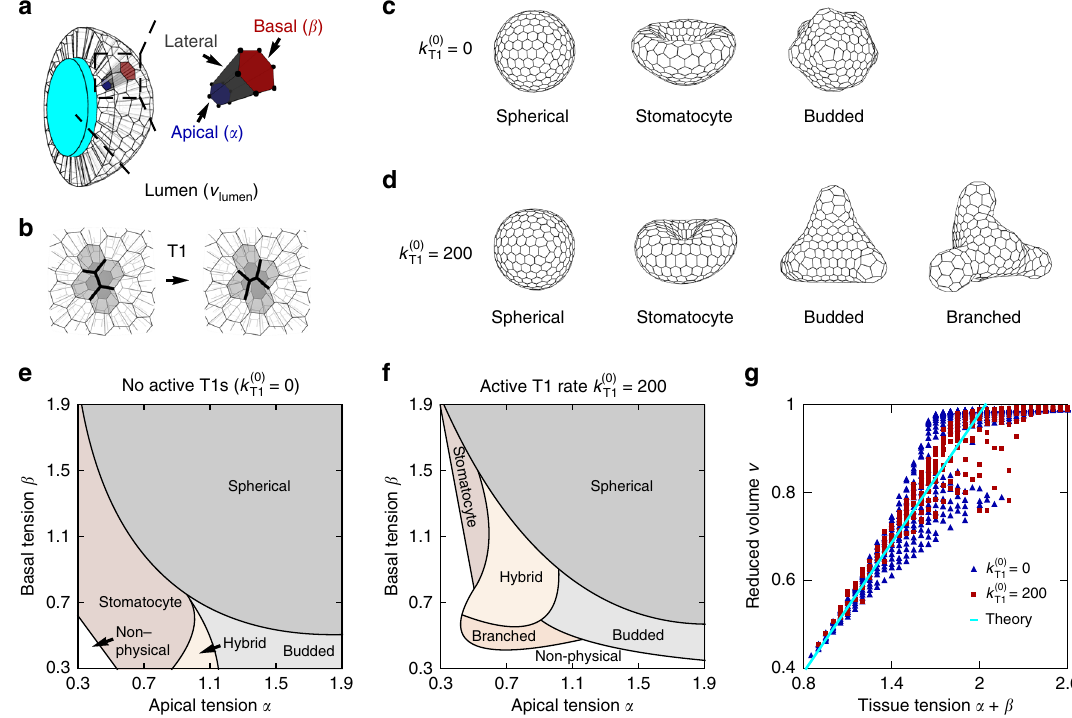
Fig. 1 Mechanical model predicts several characteristic morphologies. a Schematics of the model epithelial shell with a lumen of volume v lumen (expressed in units of cell volume V cell ) indicated in cyan, and a cell with apical, lateral, and basal sides; also indicated are the dimensionless apical and basal tensions α and β , respectively. b T1 transition. c Representative shapes with N c = 300 cells, v lumen = 100, and k ð 0 Þ stomatocyte ( α = 0.7, β = 0.5), and budded ( α = 1.5, β = 0.3) morphologies. Panel d shows model epithelial shells at the same N c and v lumen but with k ð 0 Þ ¼ 200: spherical ( α = 1.2, β = 1.2), stomatocyte ( α = 0.5, β = 1.1), budded ( α = 1.1, β = 0.5), and branched ( α = 0.7, β = 0.5) morphologies. e Phase T 1 ¼ 0 shapes in the ( α , β ) plane. f Phase diagram at the same N diagram of the N c = 300, v lumen = 100, and k ð 0 Þ T 1 g Reduced volume v vs. tissue tension α + β . The solid cyan line is a theoretical prediction of the relation in non-spherical shapes [Eq.